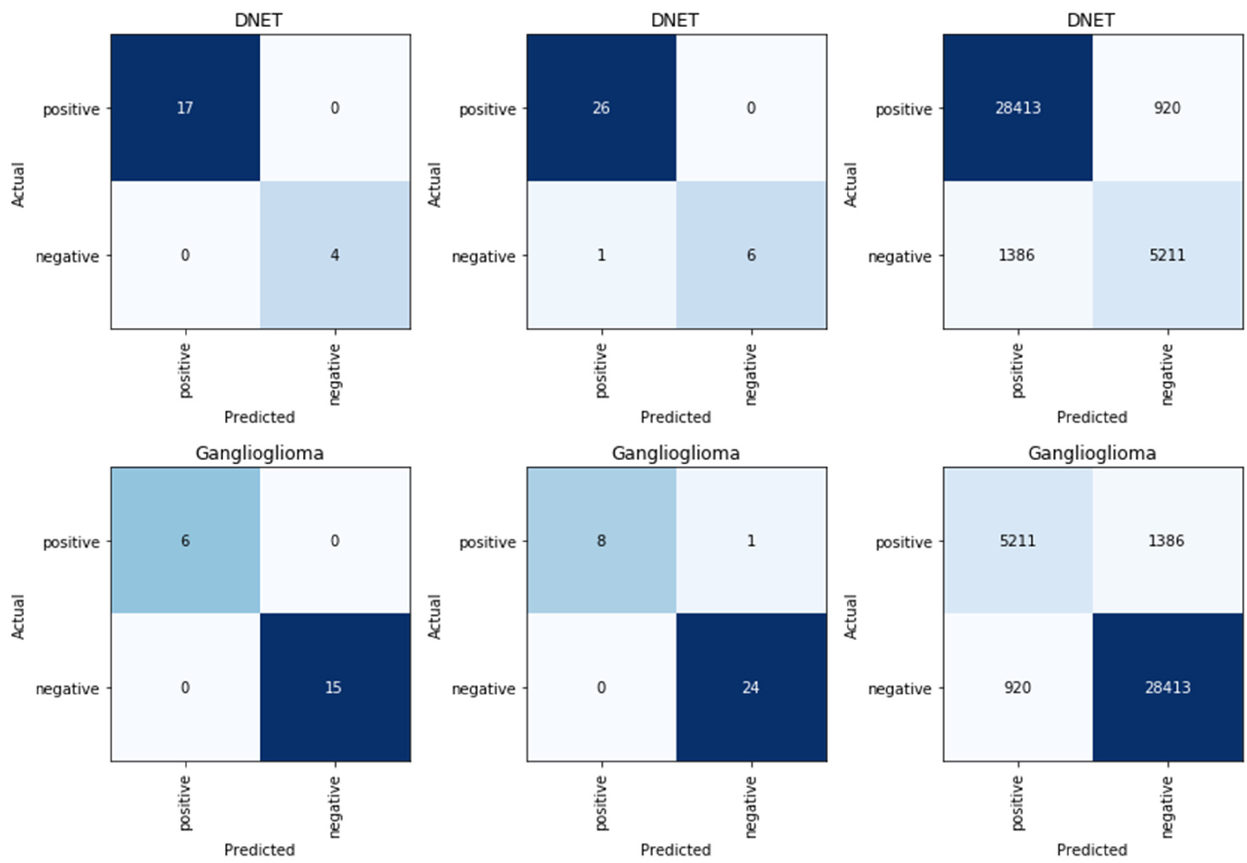
Figure 3. Results Confusion Matrices from left to right: case level, slide level, tile level.